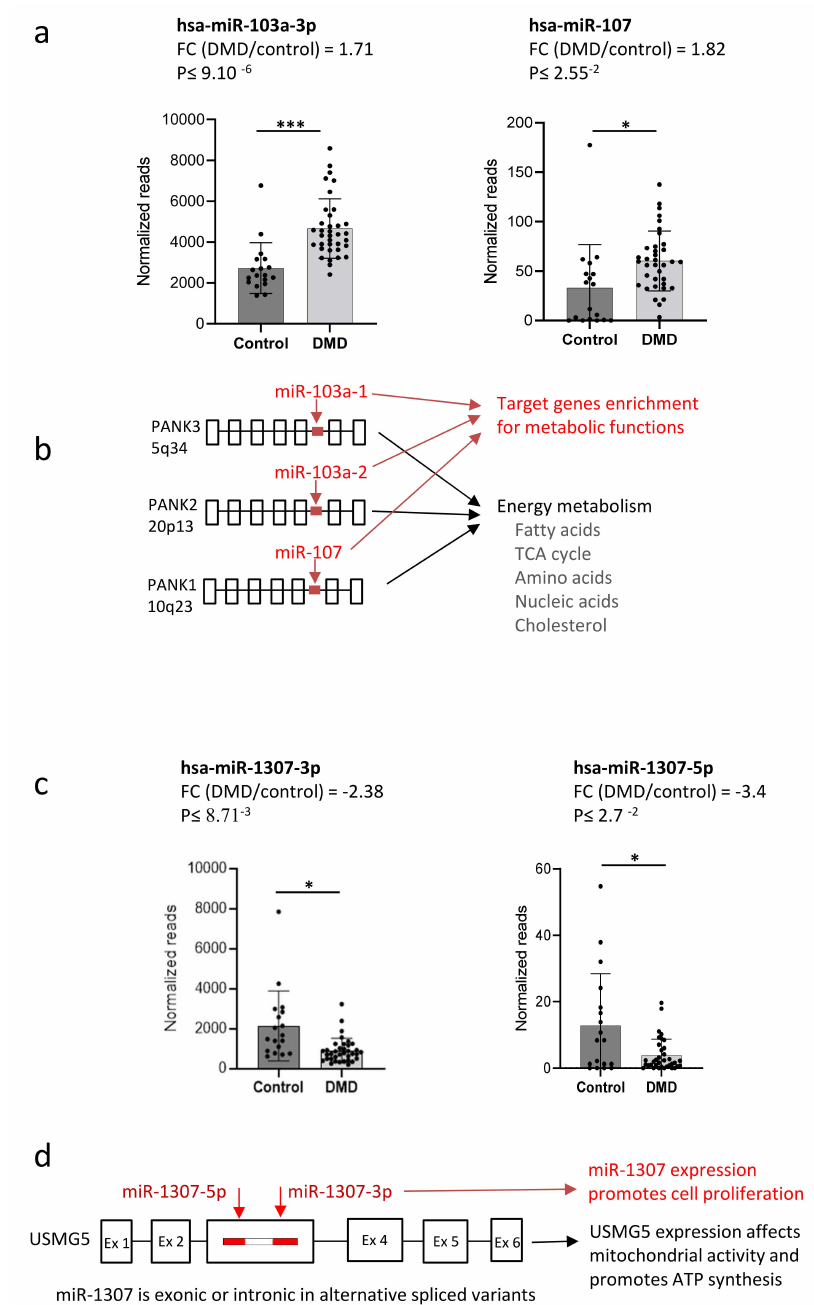
Figure 2. Dysregulated miRNAs may act coordinately with their host genes in DMD. ( a ) miR-103a and miR-107 are dysregulated in DMD patients. MiR-103a-1-3p and -103a-2-3p are indistinguishable by their sequence and are detected and presented together (data taken from [17]). ( b ) MiR-103a-1, -103a-2, and -107 are located in a highly conserved (in vertebrates) position in the PANK genes. PANK enzymes catalyze a rate-limiting step in the synthesis of CoA, an essential cofactor for a wide range of energy metabolism reactions. Bioinformatics target gene analysis for miR-103/107 predicts enrichment for metabolic pathways. ( c ) miR-1307 is downregulated in DMD (data taken from [17]). ( d ) miR-1307 is hosted by USMG5 . Reduced miR-1307 expression may restrict cell proliferation while USMG5 level may affect ATP synthesis (see main text for more details). P values are indicated as * for p < 0.05 and *** for p < 0.0005. Gene structure schematic presentations are not in